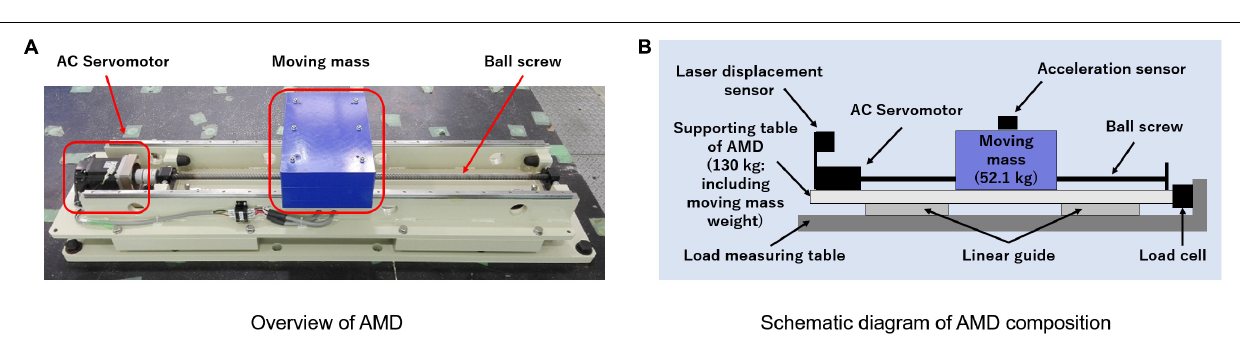
FIGURE 1 | Conceptual diagram of the RTHS test using two-individual actuators.